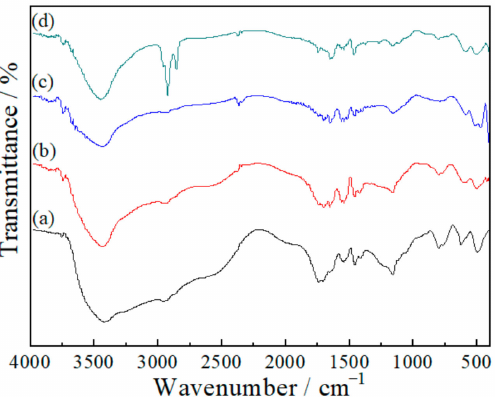
Figure 3. FTIR of PAMHA ( a ) before, and after ( b ) La(III), ( c ) Ce(III), or ( d ) Y(III)